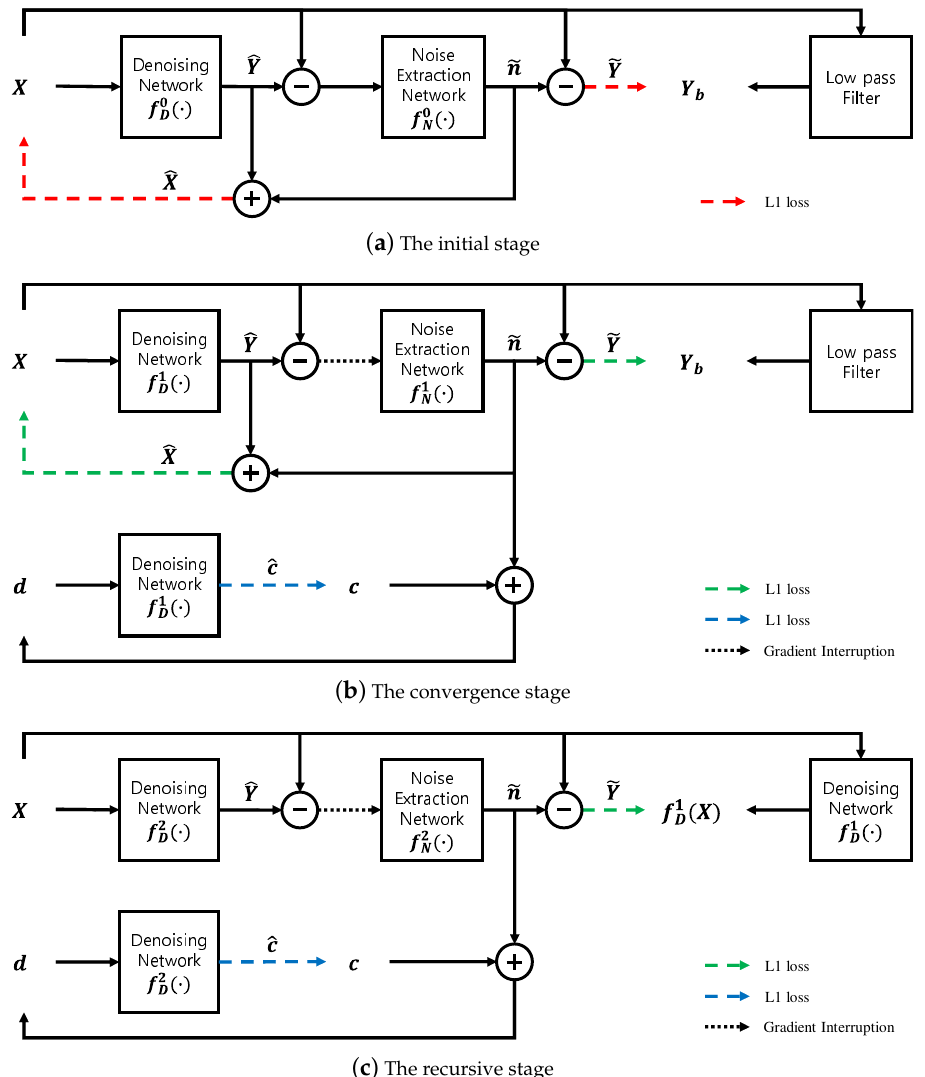
Figure 1. Block diagram of the proposed N2BeC method. ( a ) Initial, ( b ) convergence and ( c ) recursive learning